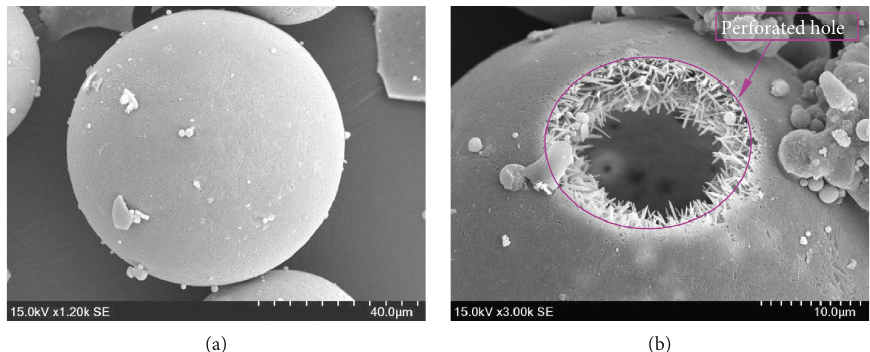
Figure 4: SEM microphotograph of the cenospheres before and after corrosion. (a) The cenospheres before corrosion. (b) The perforated cenospheres after corrosion.